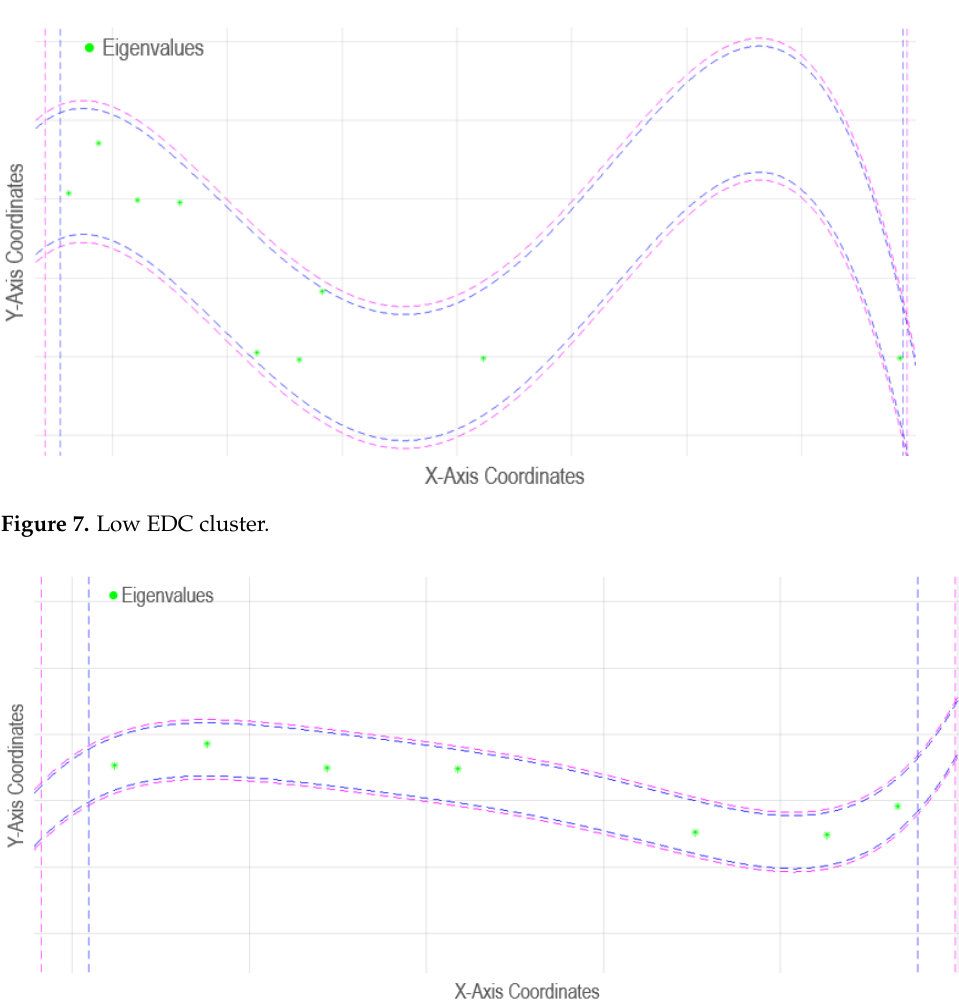
Figure 8. High EDC